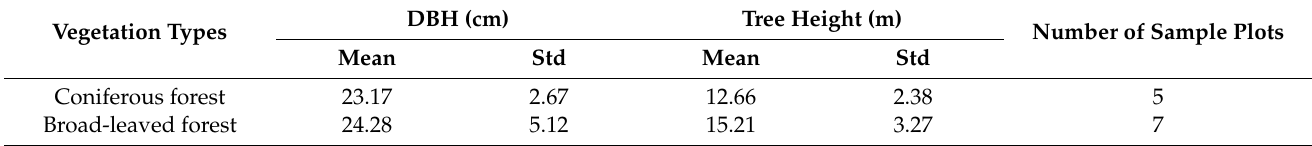
Table 1. Summary statistics of Dacrydium pierrei ( D. pierrei)